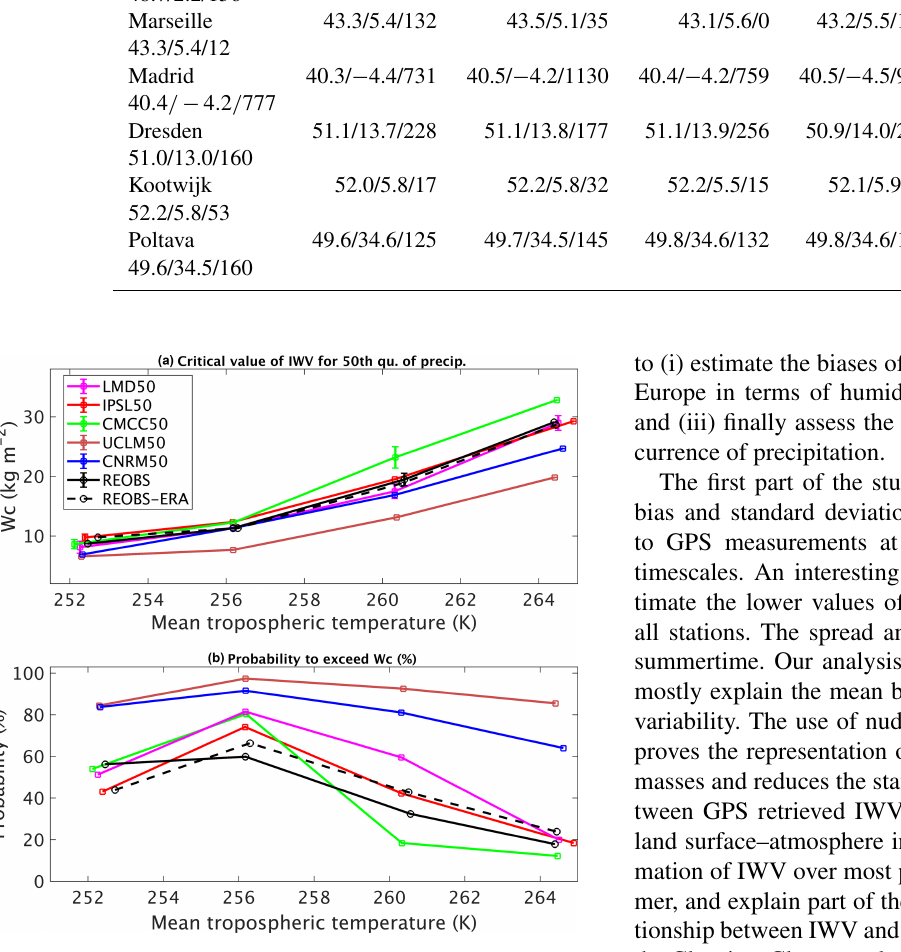
Figure 8. (a) Critical value of IWV at 48.7 ◦ N, 2.8 ◦ E over which 50th quantile precipitation significantly increases as a function of the mean tropospheric temperature. Each color corresponds to a different model (see legend for details). The period considered is 2001–2008. Solid black line is for observations from the SIRTA- ReOBS dataset between 2008 and 2015 and dashed black line is for SIRTA-ReOBS with ERA-Interim tropospheric temperature instead of tropospheric temperature from radiosoundings. (b) Probability of IWV exceeding the critical value for each